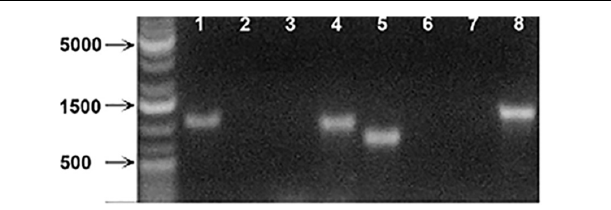
FIGURE 2 | PCR analysis of Arabidopsis SEOR insertion line mutants. (Lane 1) Atseor 1-1 with Atseor 1-1 specific T-DNA primer and flanking primer. (Lane 2) WT with Atseor 1-1 specific T-DNA primer and flanking primer. (Lane 3) Atseor 1-1 with Atseor 1-1 flanking primers. (Lane 4) WT with Atseor 1-1 flanking primers. (Lane 5) Atseor 2-1 with Atseor 2-1 specific T-DNA primer and flanking primer. (Lane 6) WT with Atseor 2-1 specific T-DNA primer and Flanking primer. (Lane 7) Atseor 2-1 with Atseor 2-1 flanking primers. (Lane 8) WT with Atseor 2-1 flanking